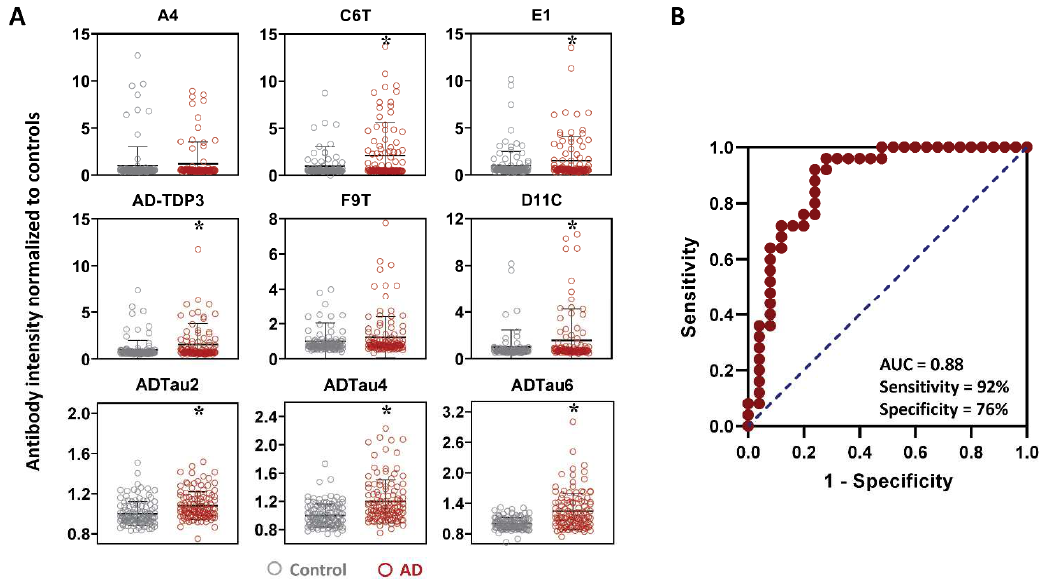
Figure 1. Analysis of all longitudinal AD and control plasma samples. ( A ) Protein variants levels of all the cases assessed using a capture ELISA and a panel of 9 scFvs. Significant differences were obtained with 7 of the 9 scFvs: 2 Aβ scFvs (C6T, E1), TDP-43 scFv (AD-TDP3), and 4 tau scFvs (D11C, ADTau2, ADTau4, and ADTau6). Data represent mean average score and standard deviation with statistical significance by ANOVA post hoc LSD * p < 0.05. ( B ) ROC (receiver operating characteristic) curve for 7 statistically significant scFvs using averaged time point ELISA values for each 25 AD and 25 control cases. From the AUC (0.88), an optimal cutoff threshold (11.00) was calculated by maximum Youden J value (0.68; sensitivity + specificity − 1), with a sensitivity of 92% and specificity 76%.